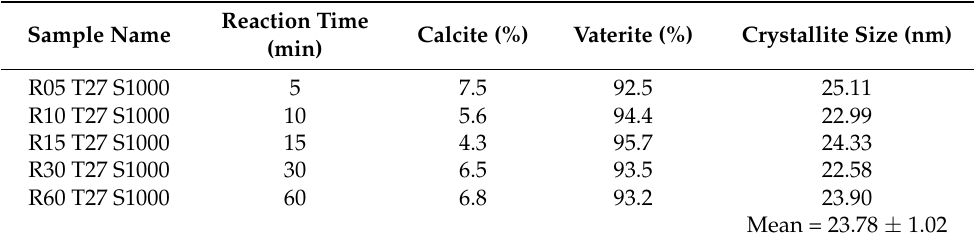
Table 5. Effect of reaction time on the as-prepared CaCO 3 polymorph ratio and size of crystallite (at a temperature of 27 ◦ C and stirring speed of 1000